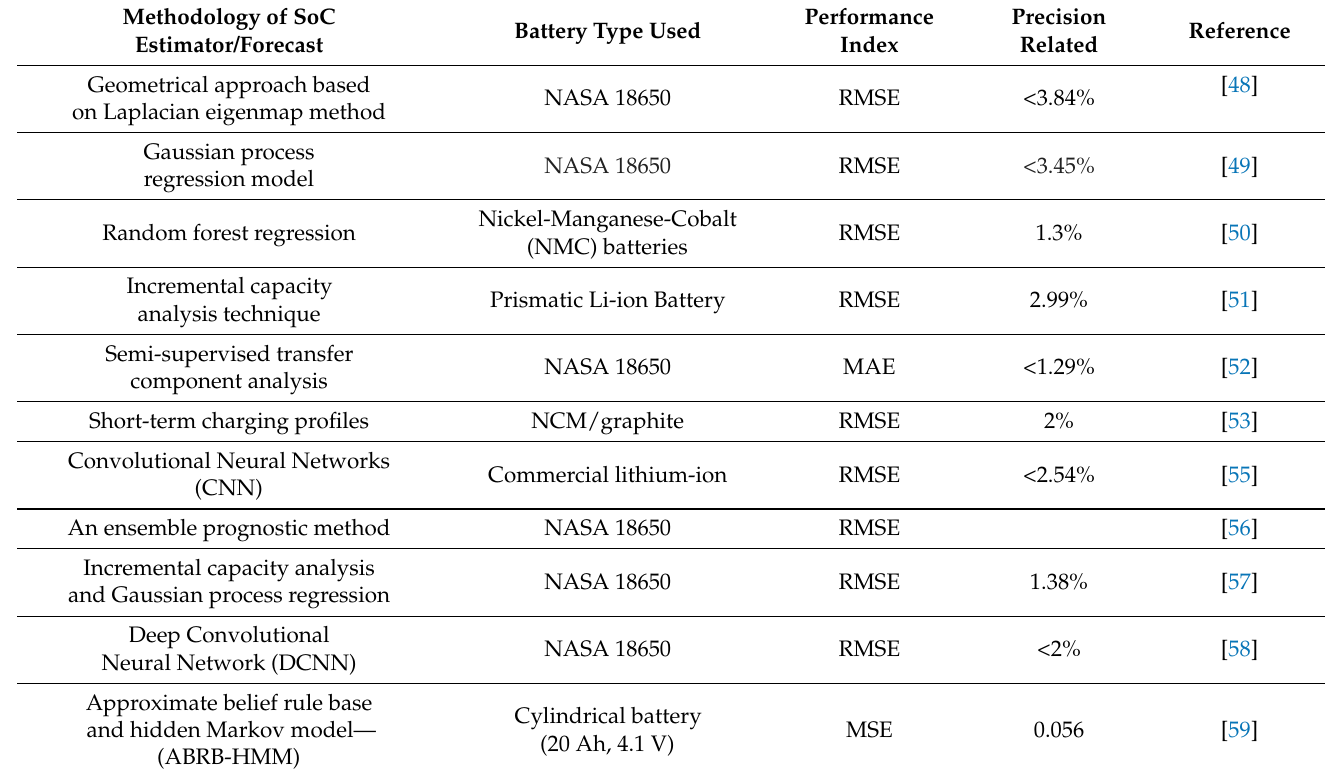
Table 1. State-of-the-art summary of SoC estimation